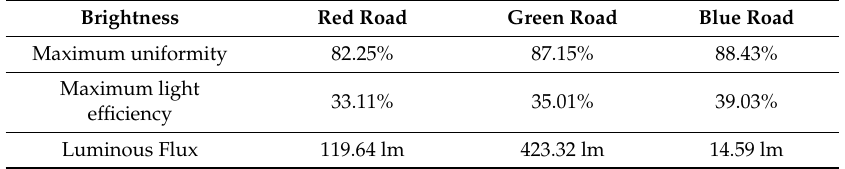
Table 3. Statistical table for the effectiveness of the projection illumination system for the